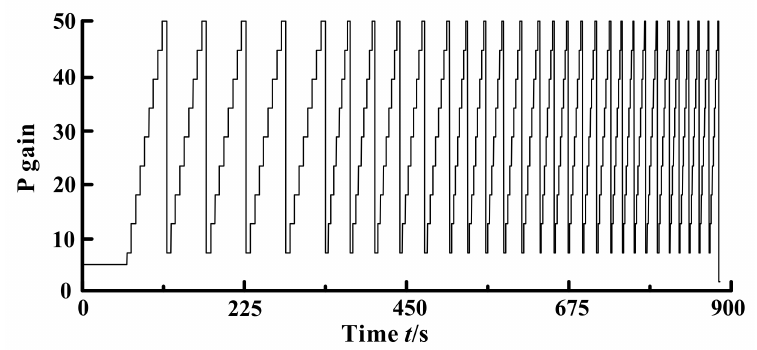
Figure 15. Control parameter signals in the experiment.